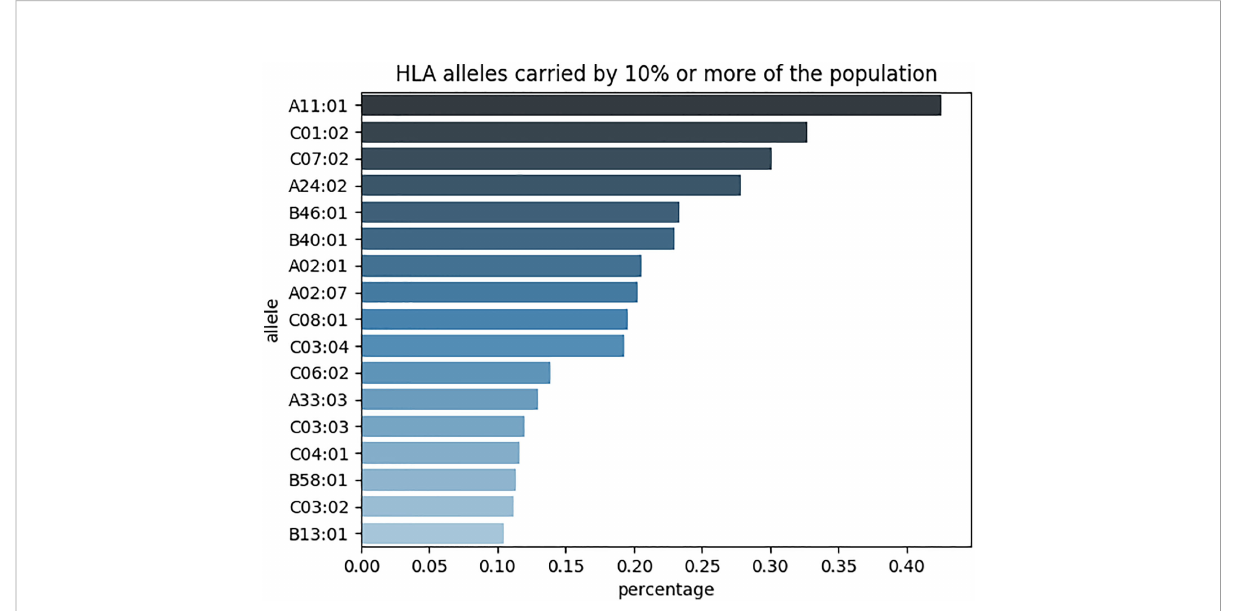
FIGURE 1 17 different HLA class I alleles (HLA-A, HLA-B, and HLA-C) were found in more than 10% of all patients